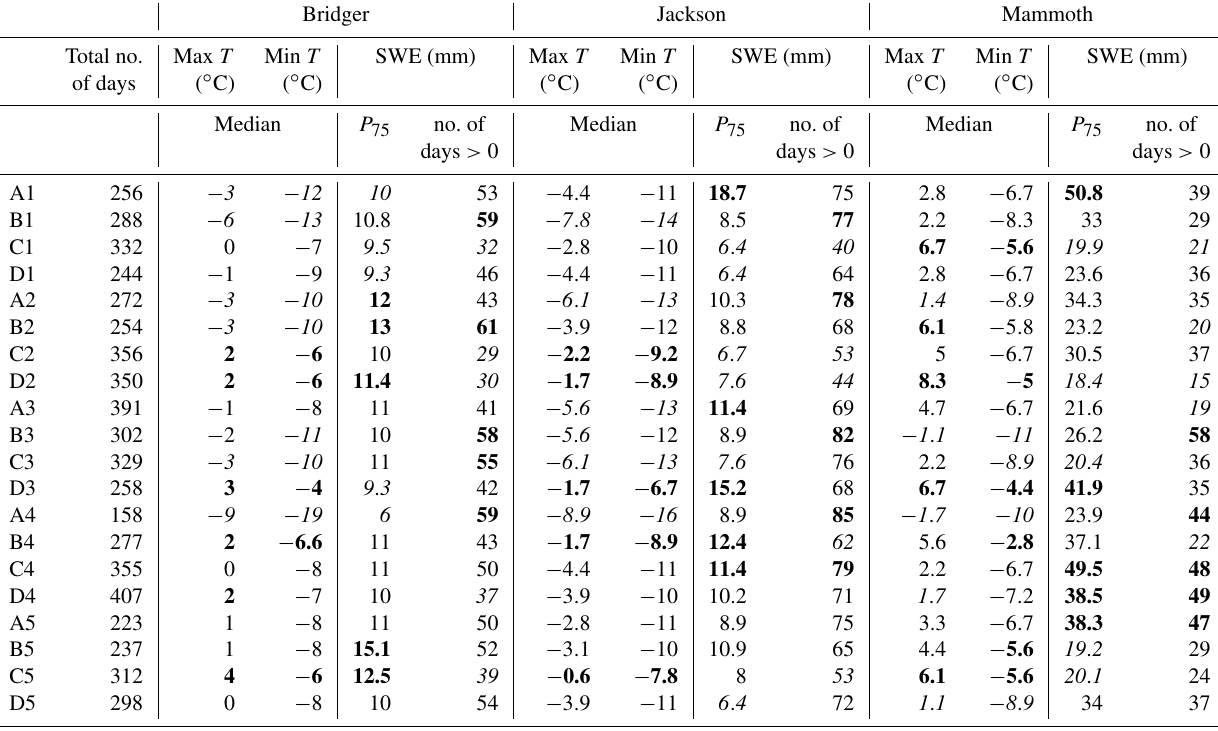
Table 3. Descriptive statistics for meteorological metrics at all three locations. SWE is summarized with the 75th percentile of daily SWE for all days assigned to each synoptic type, along with percent of total days during which any amount of precipitation was recorded. Daily maximum and minimum temperatures are summarized using median values for all days assigned to each synoptic type. For each column, the top five wettest or warmest types are highlighted in bold, while the five driest or coldest types are